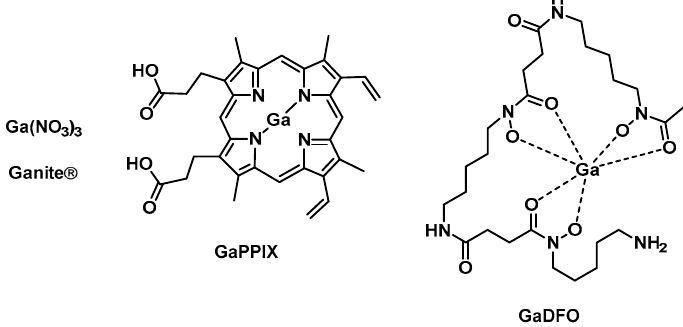
Figure 2. Examples of gallium compounds with antibacterial activities.